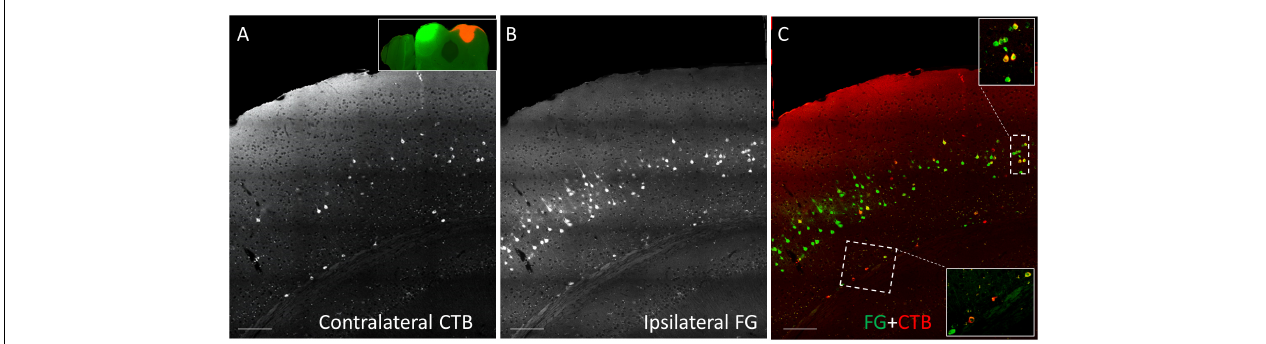
FIGURE 3 | Coronal sections showing double injection site of Fluorogold (FG) on the left and CTB-555 on the right IC. (A) Grayscale image showing contralateral CTB-555-labeled cells. (B) Grayscale image showing ipsilateral FG-labeled cells. (C) Overlay between panel (A) and panel (B) , showing single-labeled (red or green) and double-labeled (yellow) cells in each layer in insets. Scale bar = 100 µ